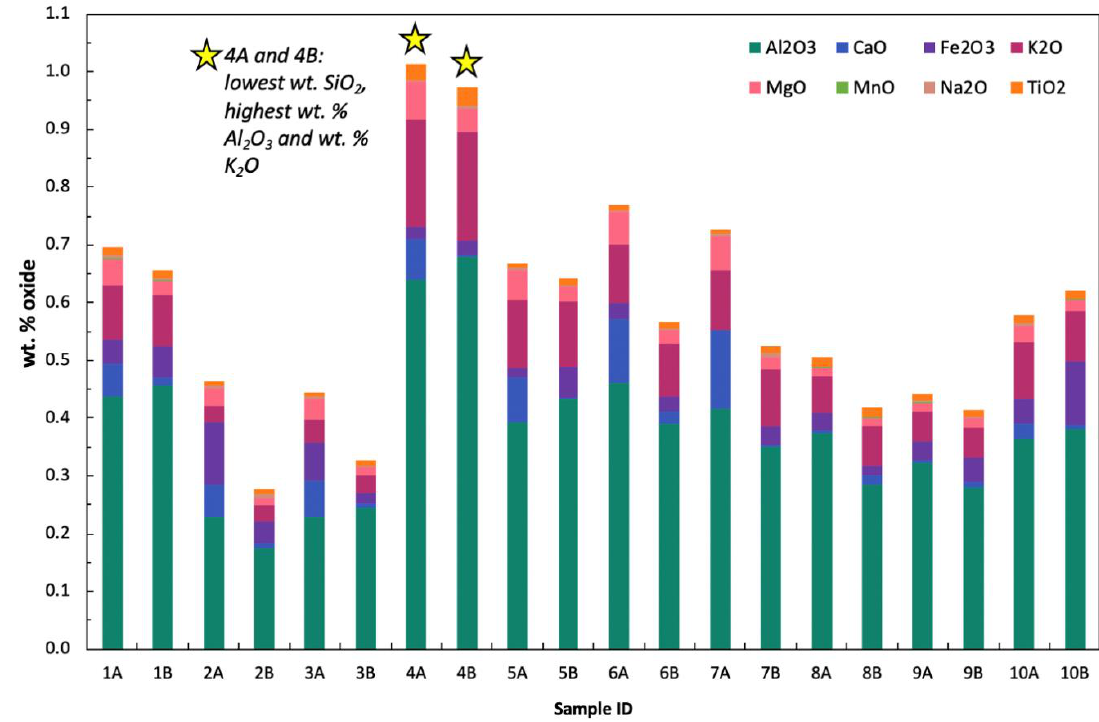
Figure 5. Major element oxide content of sampled Kinnikinic Quartz (wt. % SiO 2 not shown, see text for discussion). K 2 O and Al 2 O 3 contents characterize the majority of a sample’s bulk major oxide composition shown here, consistent with the presence of potassium feldspar. Fe 2 O 3 and MgO contents are inferred to be associated with Fe-oxides, as identified via SEM-EDS.